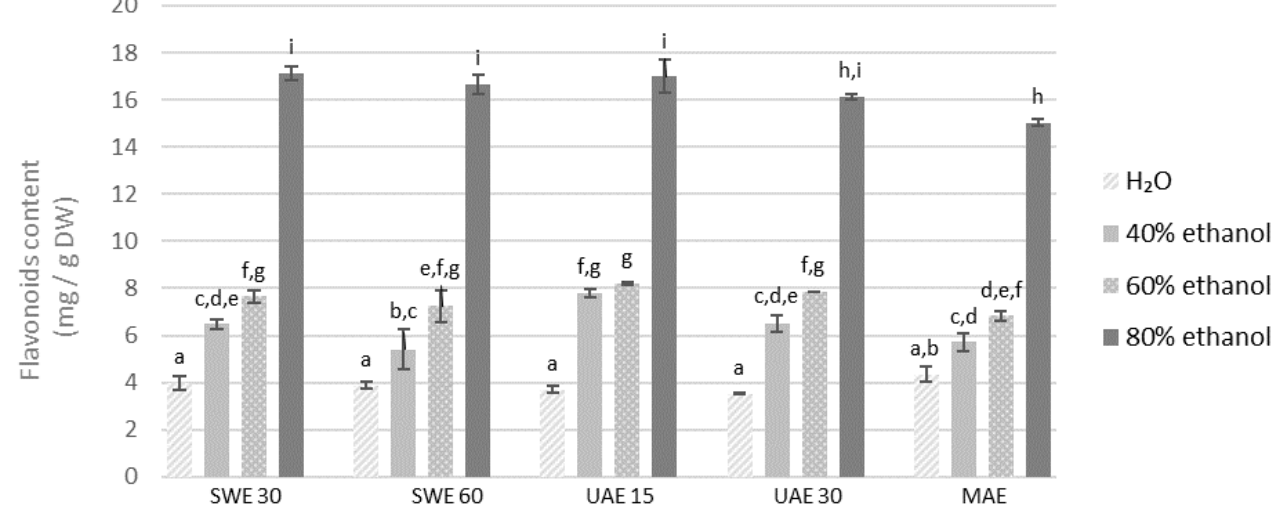
Figure 3. Flavonoids content in the extracts obtained from the fraction with particle size ≤ 0.5 mm. SWE—shaking water bath extraction; UAE—ultrasound-assisted extraction; MAE—microwave assisted extraction; 15, 30 or 60-time of extraction. Results are presented as the mean ± SD from triplicate determinations. Different letters: a, b, c, d, e, f, g, h, i indicate that samples are significantly different. The letter “a” marks the lowest value. Higher values are marked with consecutive letters of the alphabet. Bars that share the same letter within the group are not significantly different according to Tukey’s HSD test at p > 0.05.